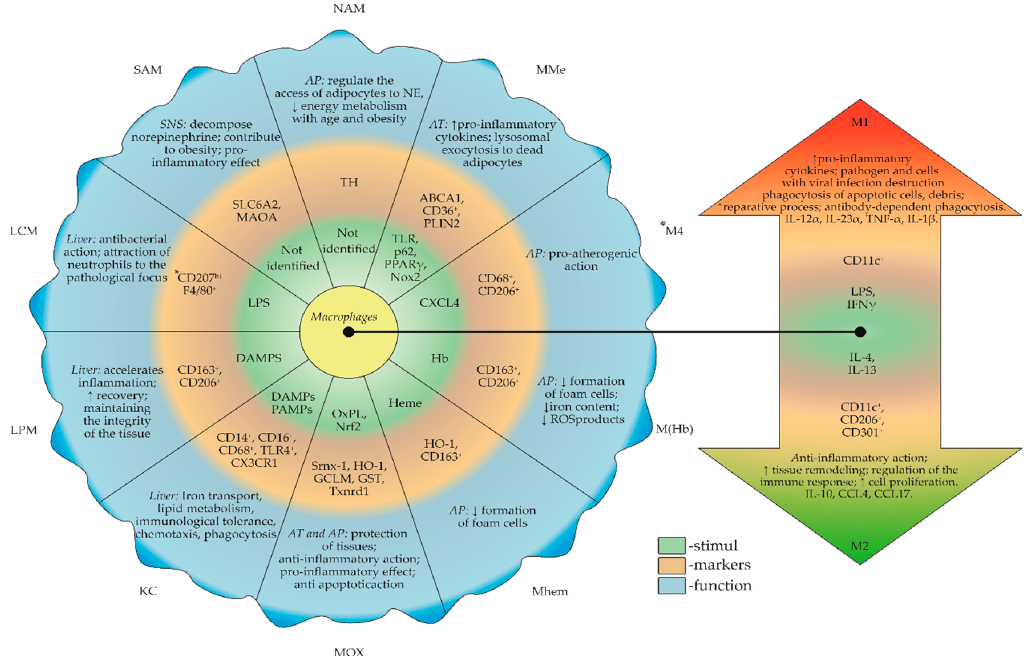
Figure 2. Inductors, markers and functions of macrophages subtypes in tissues. All macrophage subtypes may take a pro- or anti-inflammatory phenotype in obesity. MoMFs are a common precursor for subtypes of migrating macrophages in tissue. When damaged, MoMFs can assume a tissue- specific phenotype. Determining the exact origin of macrophages (resident or migratory) is a task in modern science. The plasticity of macrophages between M1 and M2 is also present in the resident